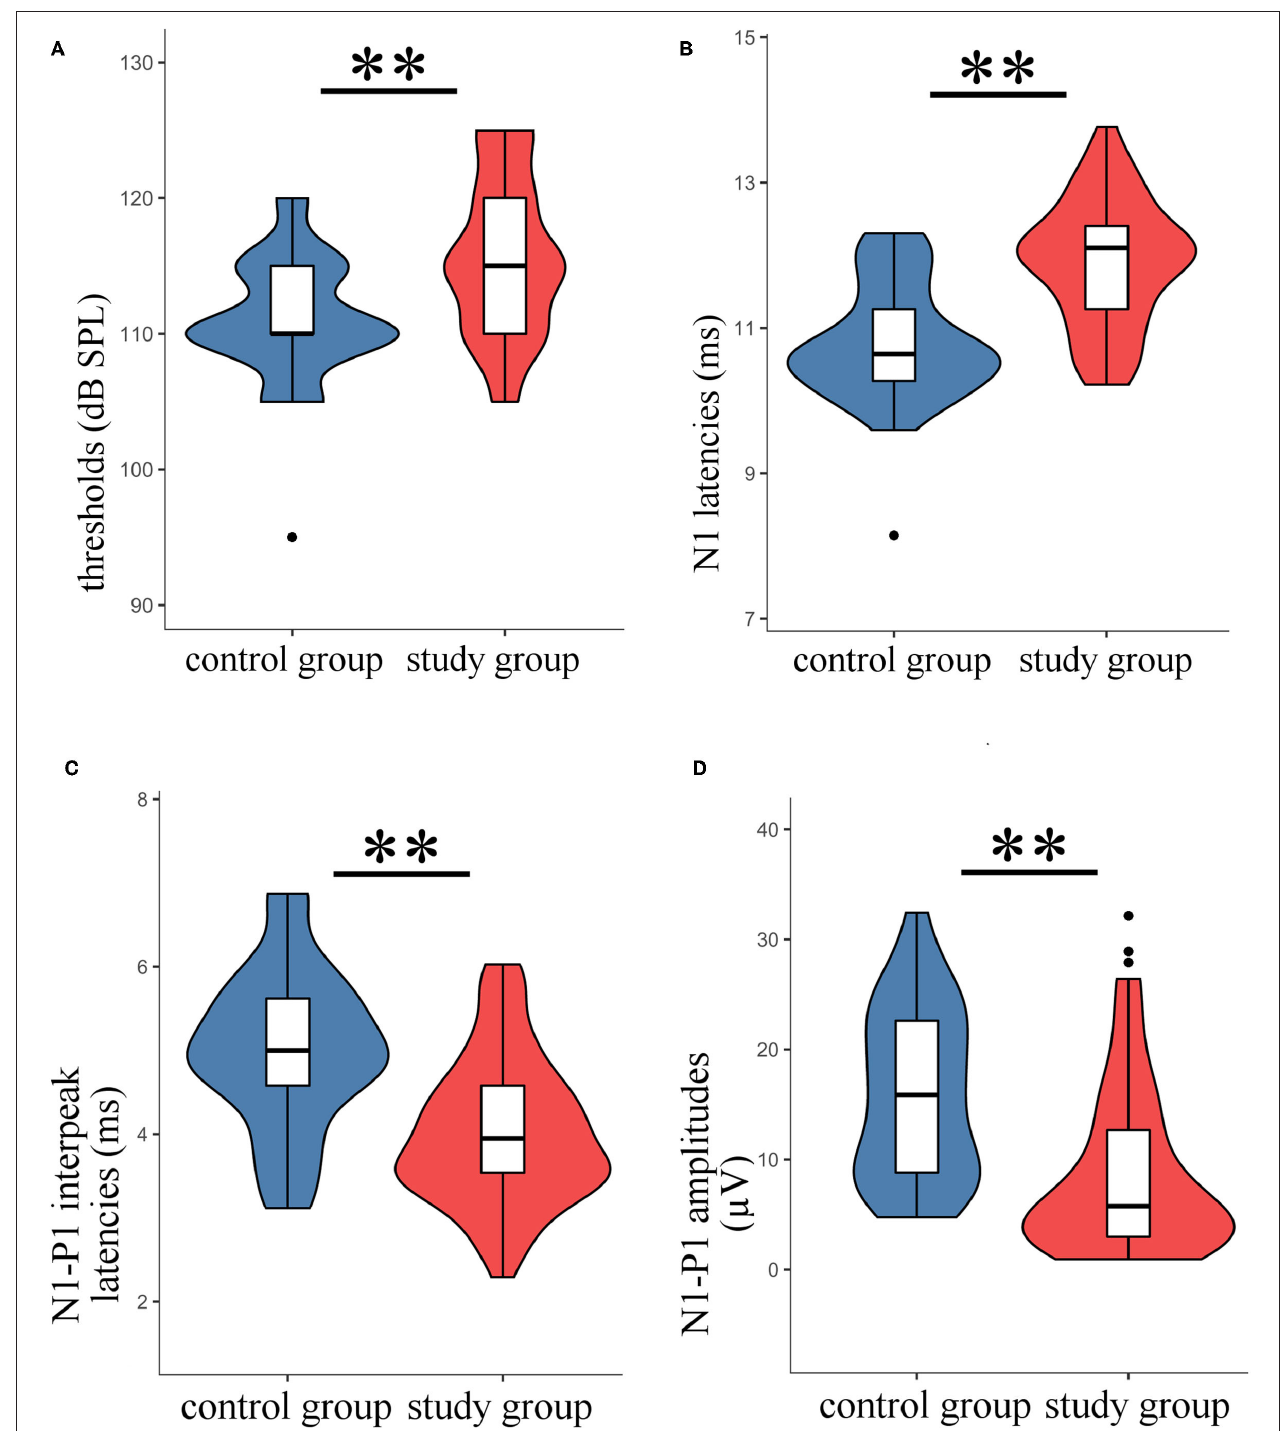
FIGURE 2 | The oVEMP parameters in the study group were compared with those of the control group. The violin plot includes the box-whisker plot inside presenting the median, interquartile range (IQR), the upper limit (third quartile + 1.5 × IQR), and the lower limit (first quartile – 1.5 × IQR), and the violin outline presenting the density distribution (The mathematical predictions beyond the upper and lower limits were truncated because the boundary effect has no practical significance for this study.). (A) Thresholds; (B) n1 latencies; (C) n1-p1 interpeak latencies; (D) n1-p1 amplitudes; ** t -test, p < 0.001.